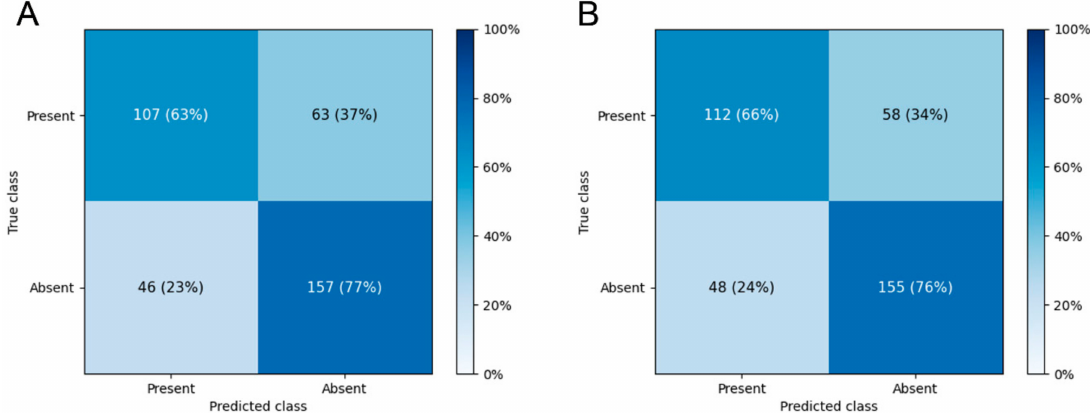
Figure 2. Receiver operating characteristic curves of deep learning models predicting the presence of white matter hyperintensity.